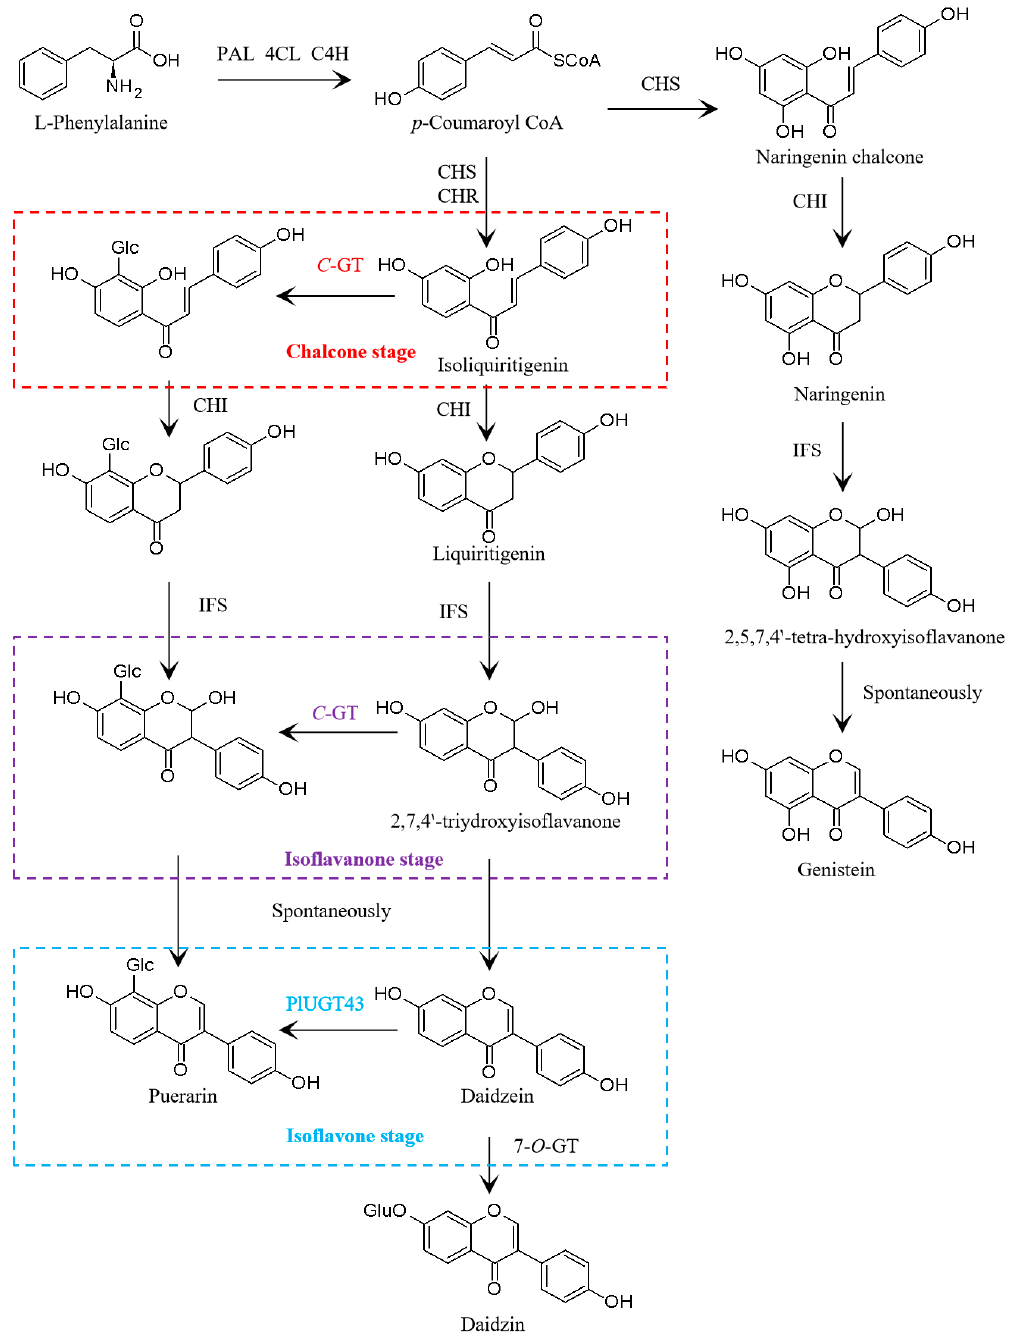
Figure 1. The proposed pathway for the biosynthesis of puerarin. PAL represents phenylalanine ammonia-lyase, C4H represents cinnamate 4-hydroxylase, 4CL represents 4-coumarate:CoA lig- ase, CHS represents chalcone synthase, CHI represents chalcone isomerase, CHR represents chal- cone reductase, IFS represents isoflavone synthase, and C -GT represents C -glucosyltransferase. C - glucosylation during puerarin biosynthesis may take place at the chalcone, isoflavanone, or isoflavone stage. At the isoflavone stage, PlUGT43 catalyzes 8- C -glucosylation, converting daidzein to puer- arin